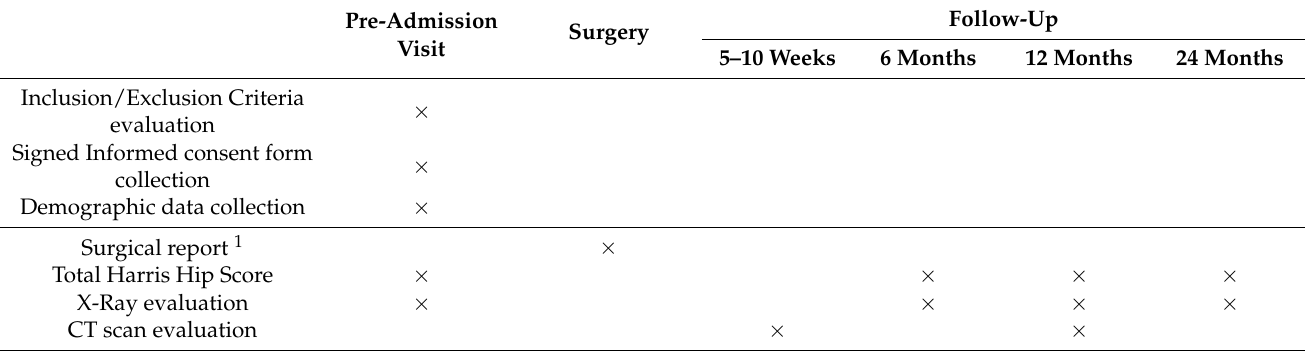
Table 2. Schedule of pre-hospitalisation, intervention, and assessments in the